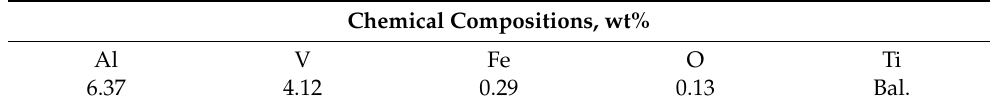
Table 1. Chemical compositions of Ti-6Al-4V